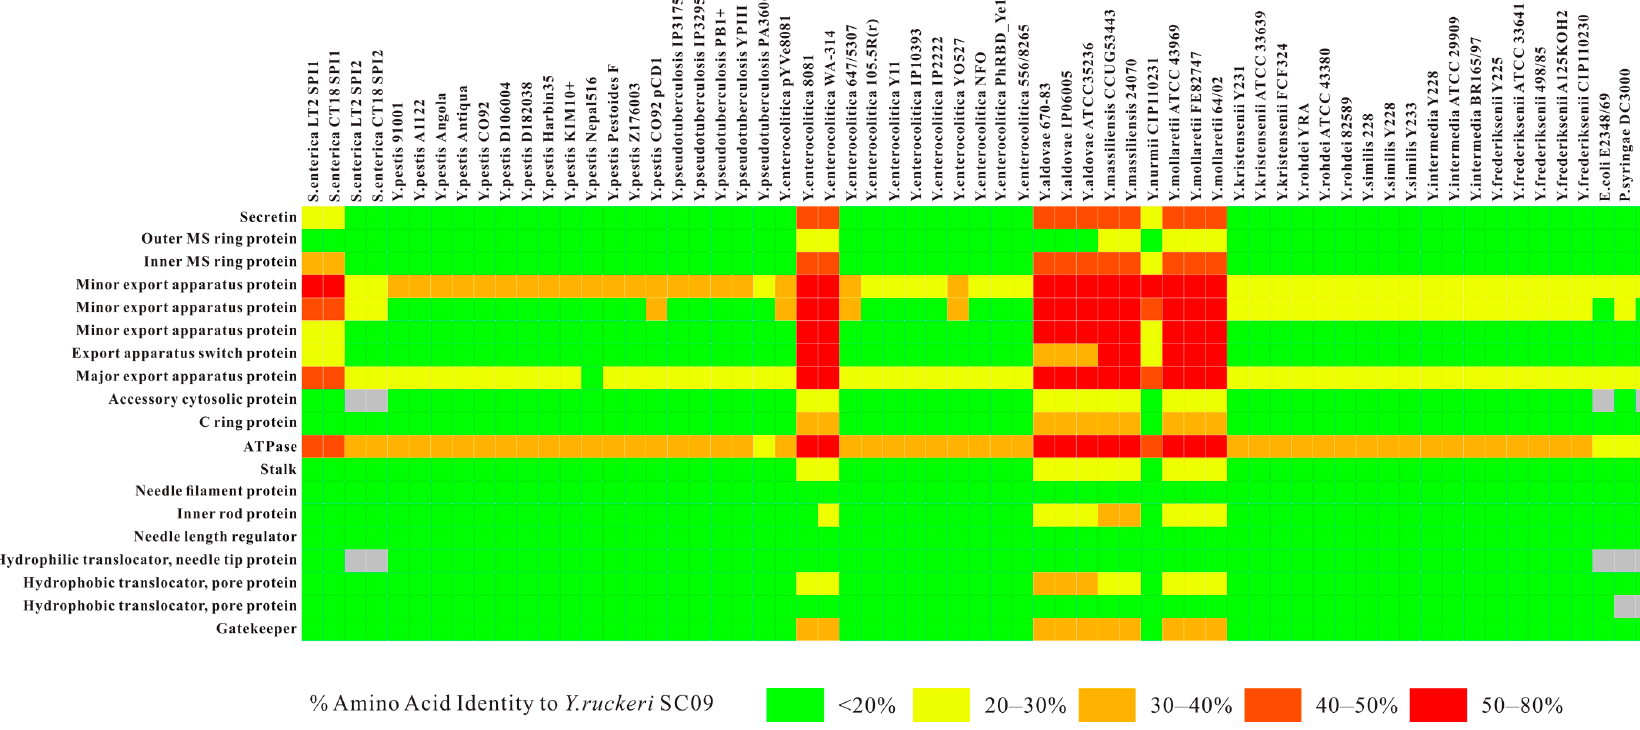
Figure 5. Homologous proteins and their function in various families of T3SSs from different bacteria. Heat map colors are based on the amino acid identity of genes across the T3SS, as indicated in the picture. The percent identities were identified using BLAST searches of the assembled genomes. Amino acid sequences from SC09 act as the comparator sequences.